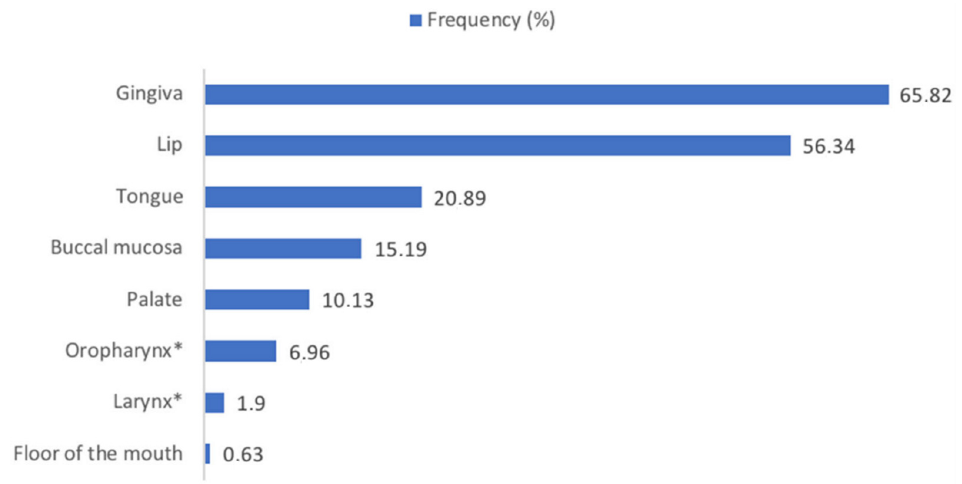
Figure 2. Frequency of the oral sites involved by o-PCM. * Percentage of cases in which a pharyngeal and laryngeal extension beyond the oral one is reported. Table 3. Distribution of clinical manifestations of o-PCM by anatomical